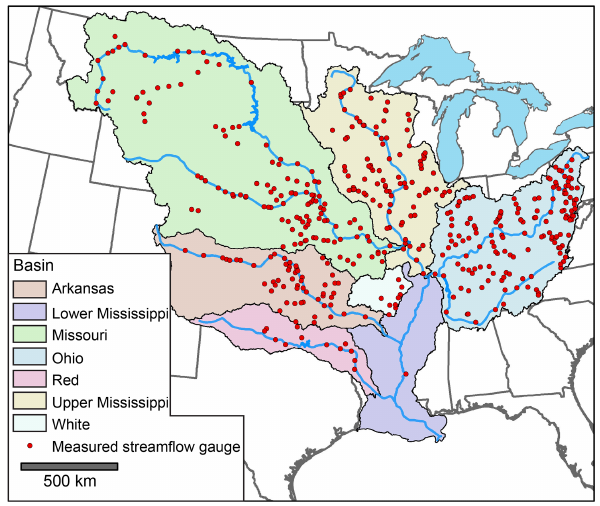
Figure 1. Major sub-basins of the Mississippi and USGS gauging stations used for width